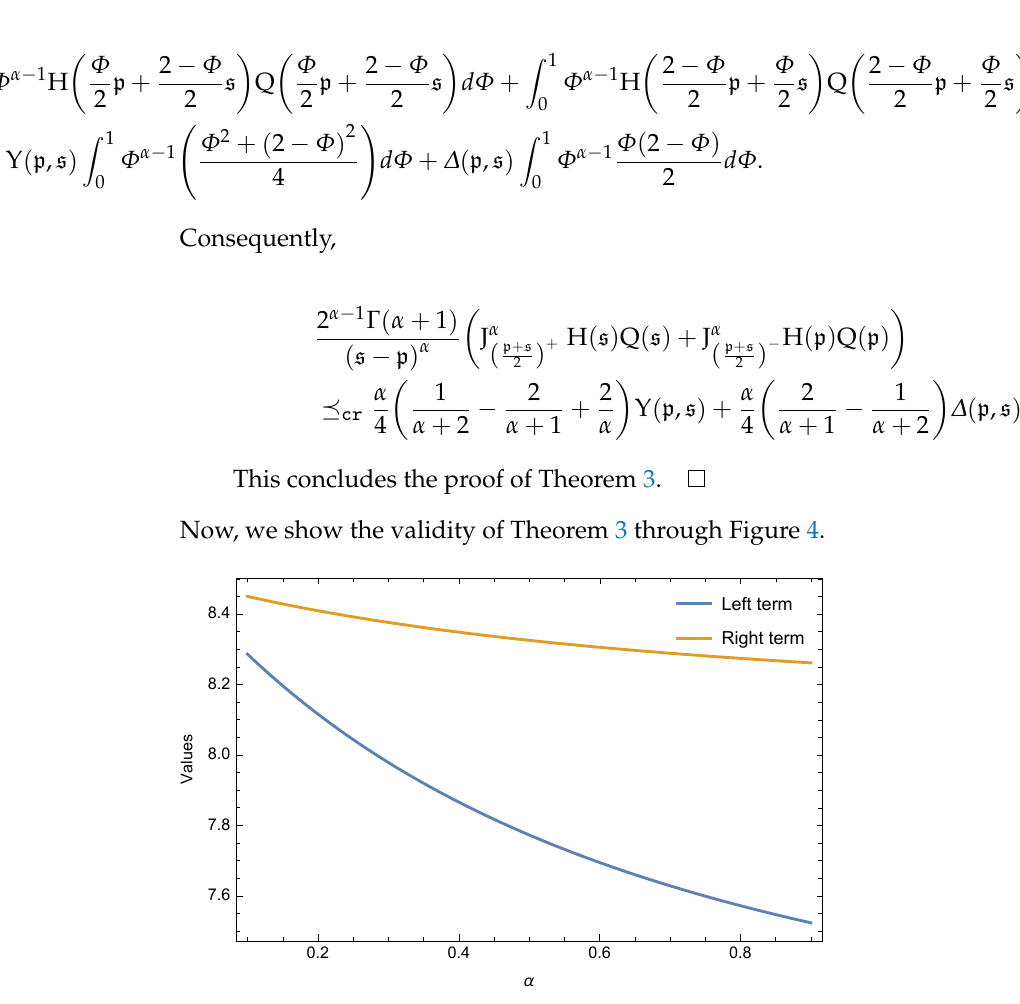
Figure 4. Graphical behavior of Theorem 3 from the values of Table 3 for 0 < α < 1. Table 3. Numerical validation of Theorem 3 for Examples 1 and 2. Values of α Center Values of the Left Term Center Values of the Right